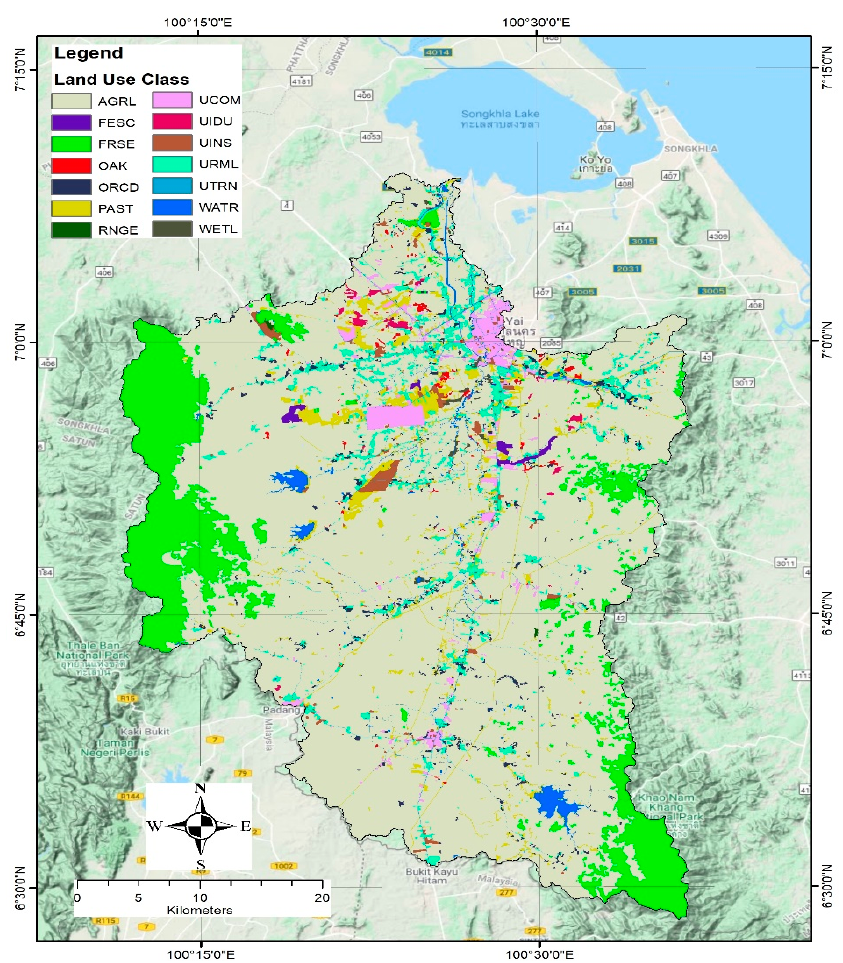
Figure 4. The land-use map of the U-Tapao river basin (URB) (use color) .